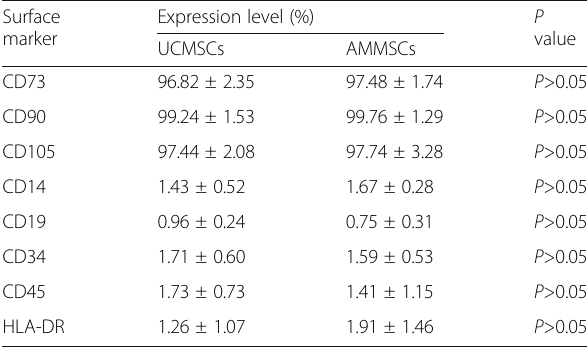
Table 1 Surface marker expression levels of UCMSCs and AMMSCs in PL Surface marker